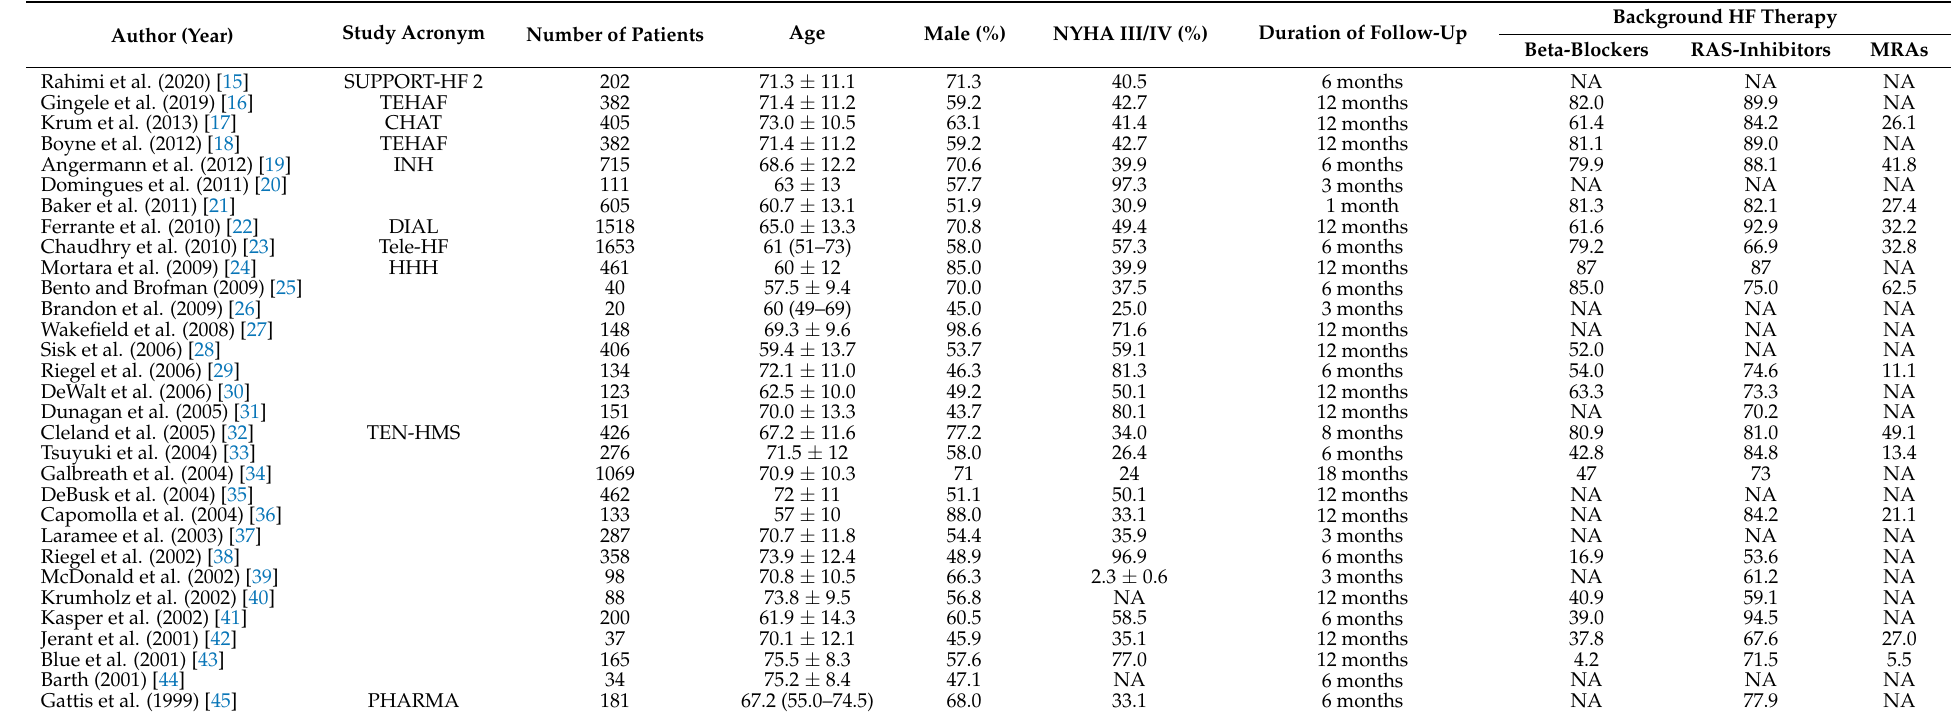
Table 1. Baseline characteristics and background HF therapy in studies investigating structured telephone support in HF